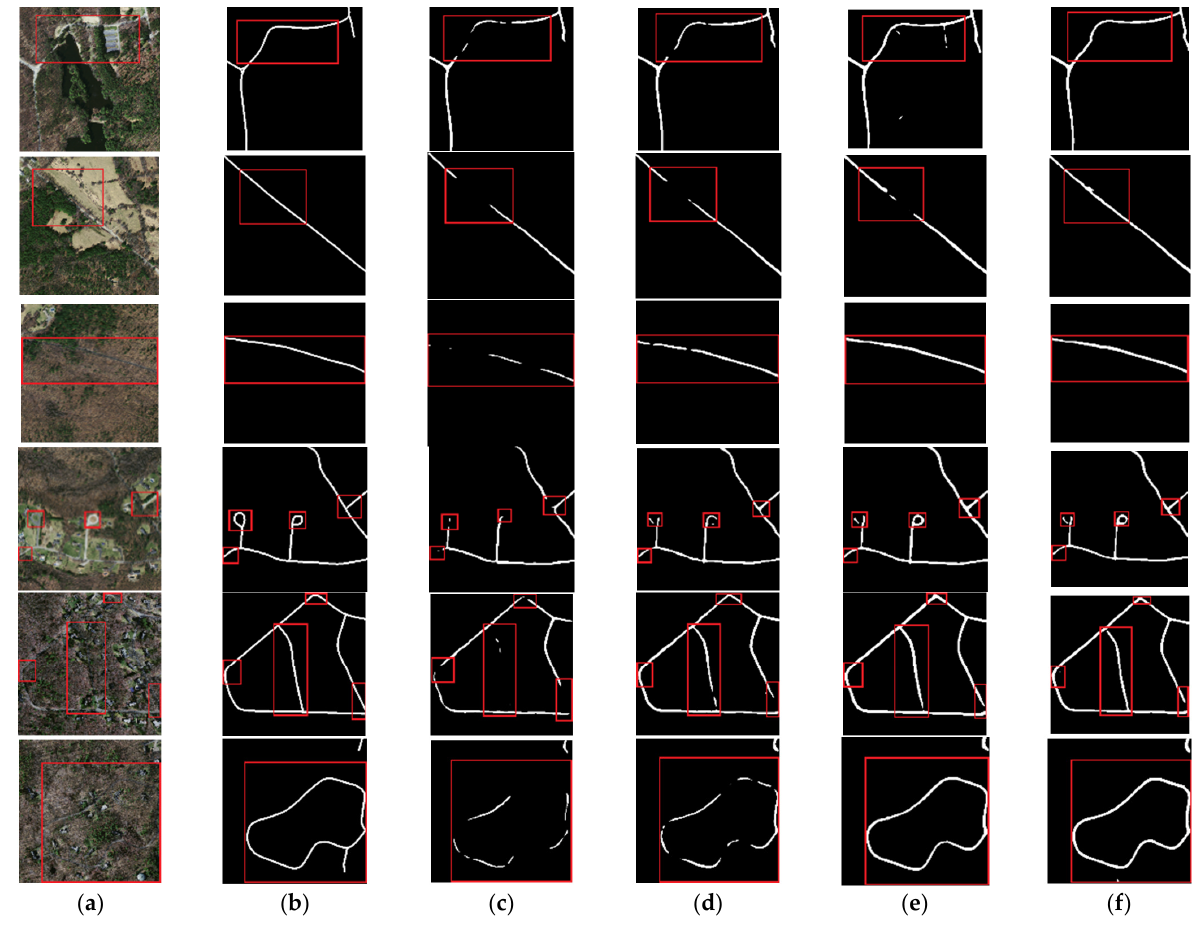
Figure 9. Comparison of adding MSPM and FEM. ( a ) Image; ( b ) Label; ( c ) Baseline; ( d ) Baseline + MSPM (L1); ( e ) Baseline + MSPM (L1 + L2); and ( f ) Baseline + MSPM (L1 + L2 + L3).( Red squares represent key areas.).